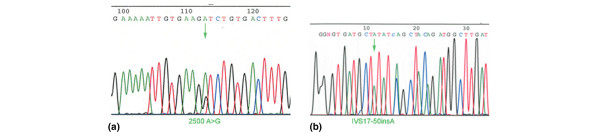
Platelet-derived growth factor receptor α (PDGFR-α) sequencing results for exon 18 (forward strand). (a) 2500A→G (1834V) DNA sequence alteration; (b) IVS17-50insA intronic insertion.